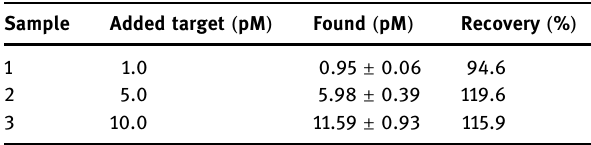
Table 3: Target DNA recovery tests with